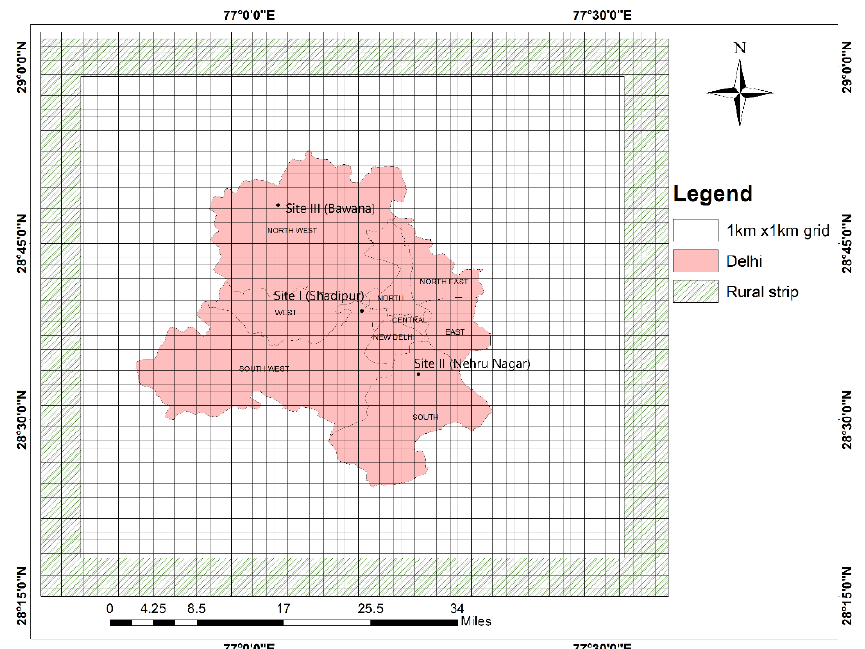
Figure 1. Study area: Delhi.